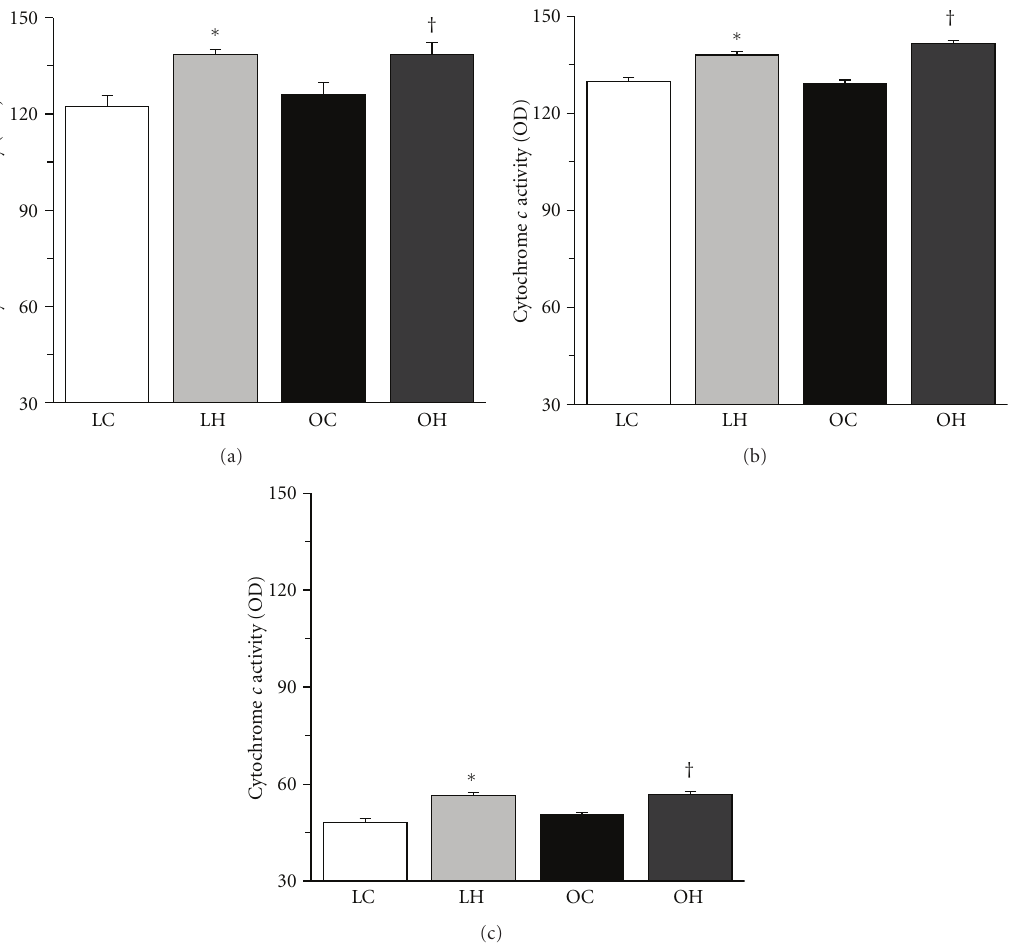
Figure 6: Cytochrome c activities of type I (a), IIA (b), and IIB (c) fibers in the extensor digitorum longus muscle. The values of cytochrome c activity are presented as the mean ± SEM. ∗ and † are significantly di ff erent from the LC and OC groups, respectively, at P < 0 . 05. In each muscle fiber type, over 100 muscle fibers were measured.